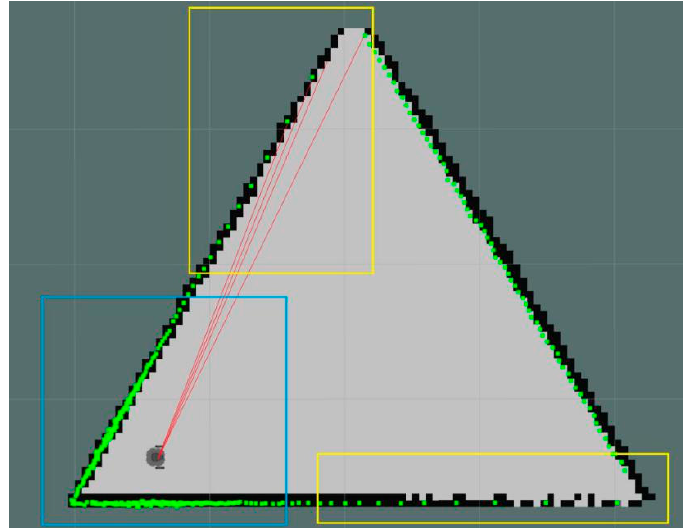
Figure 7. Turtlebot3_burger scanning data in an equilateral triangle